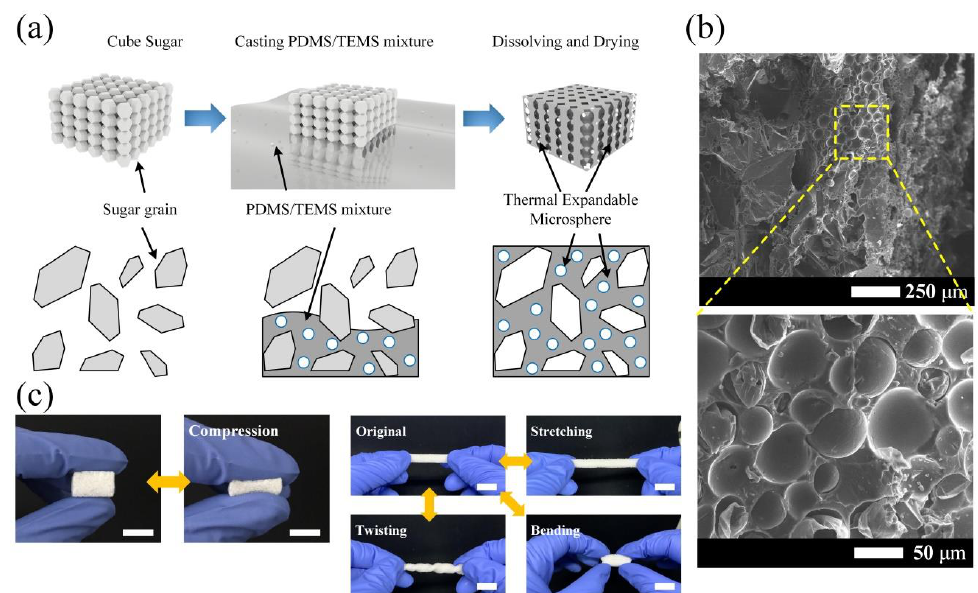
Figure 1. Fabrication process and photos of the PDMS/MS composite. ( a ) Schematic of the PDMS/MS composite using the sugar templating process with precursor solution. The empty spaces of the sugar cube are filled with the PDMS/MS precursor owing to capillary effect. ( b ) FE-SEM images of 3-D porous structure of the PDMS/MS composite. MS are arranged and exposed on the surface of the PDMS/MS composite structure. ( c ) Photographs of fabricated 3-D porous structure and mechanical deformation under various modes; compression, stretching, twisting and bending. (Scale bar: 1 cm).